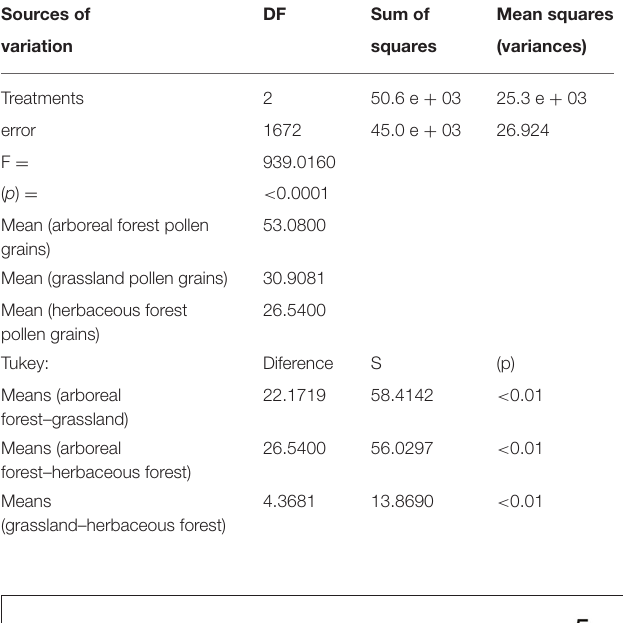
TABLE 4 | Significances between the size of pollen grains of forest arboreous, grassland, and forest herbaceous species obtained with ANOVA-Tukey.